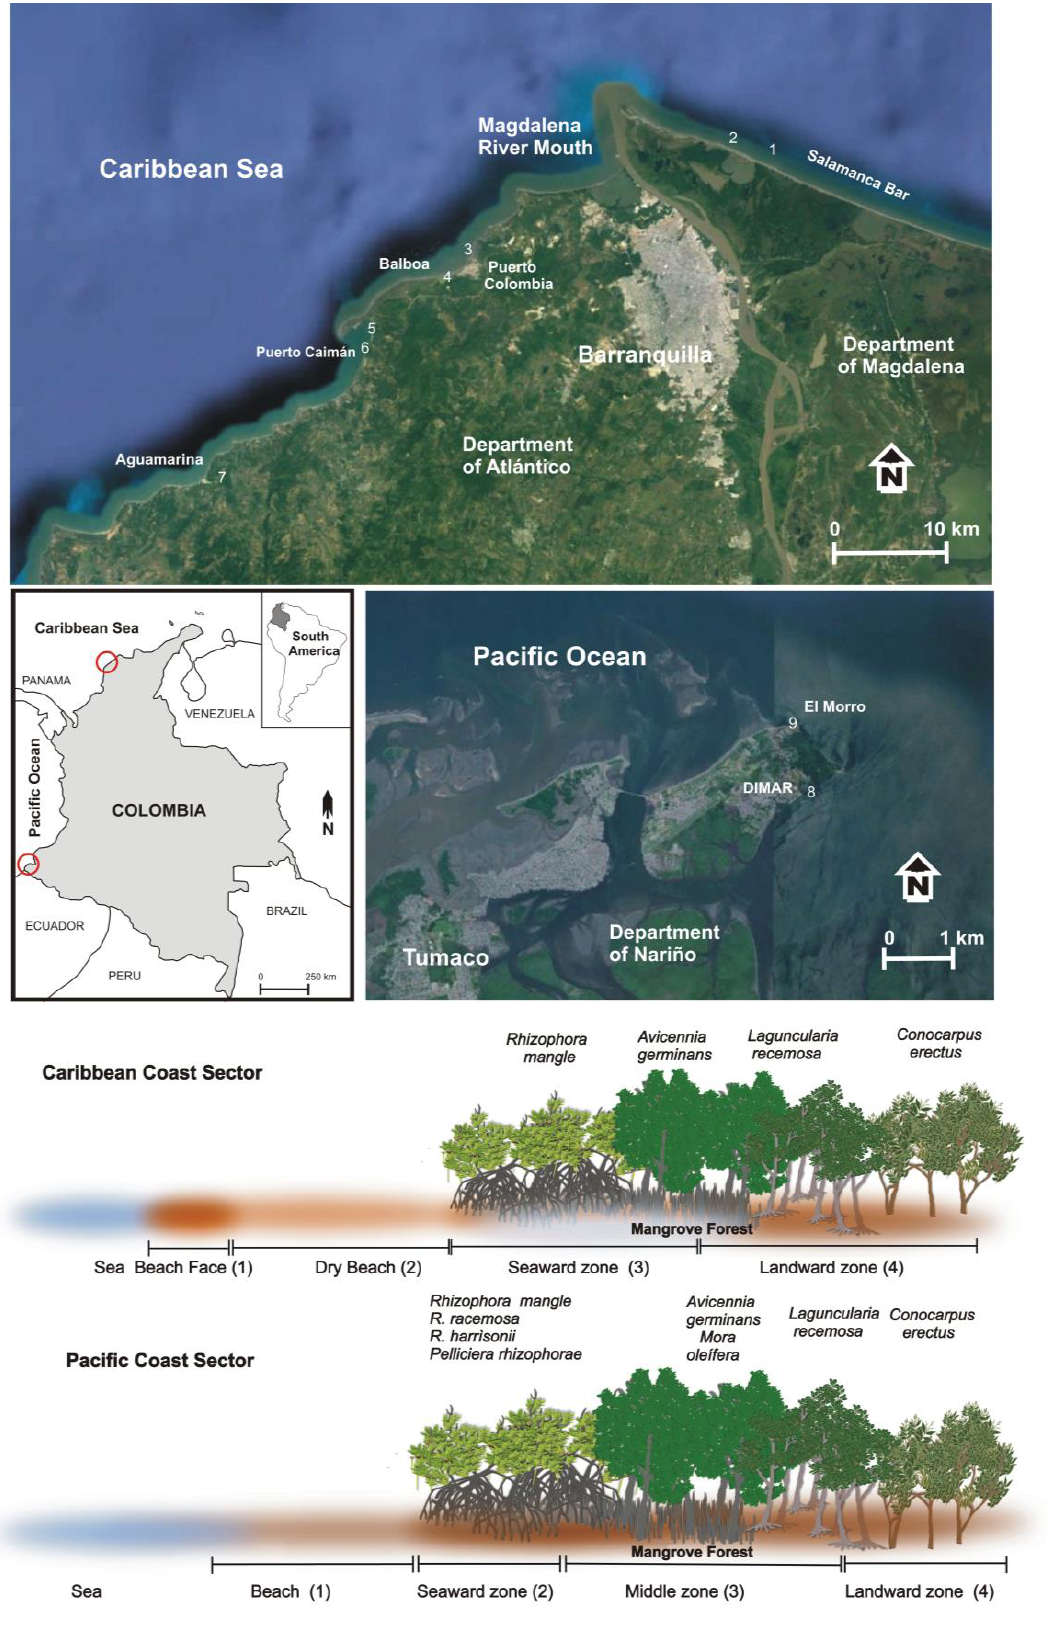
Figure 1. Location map showing the position of the nine studied sites. The investigated beaches and mangrove forest zones are also presented, as well as the typical zoning of mangrove species along the Caribbean Sea and the Pacific Ocean coasts.